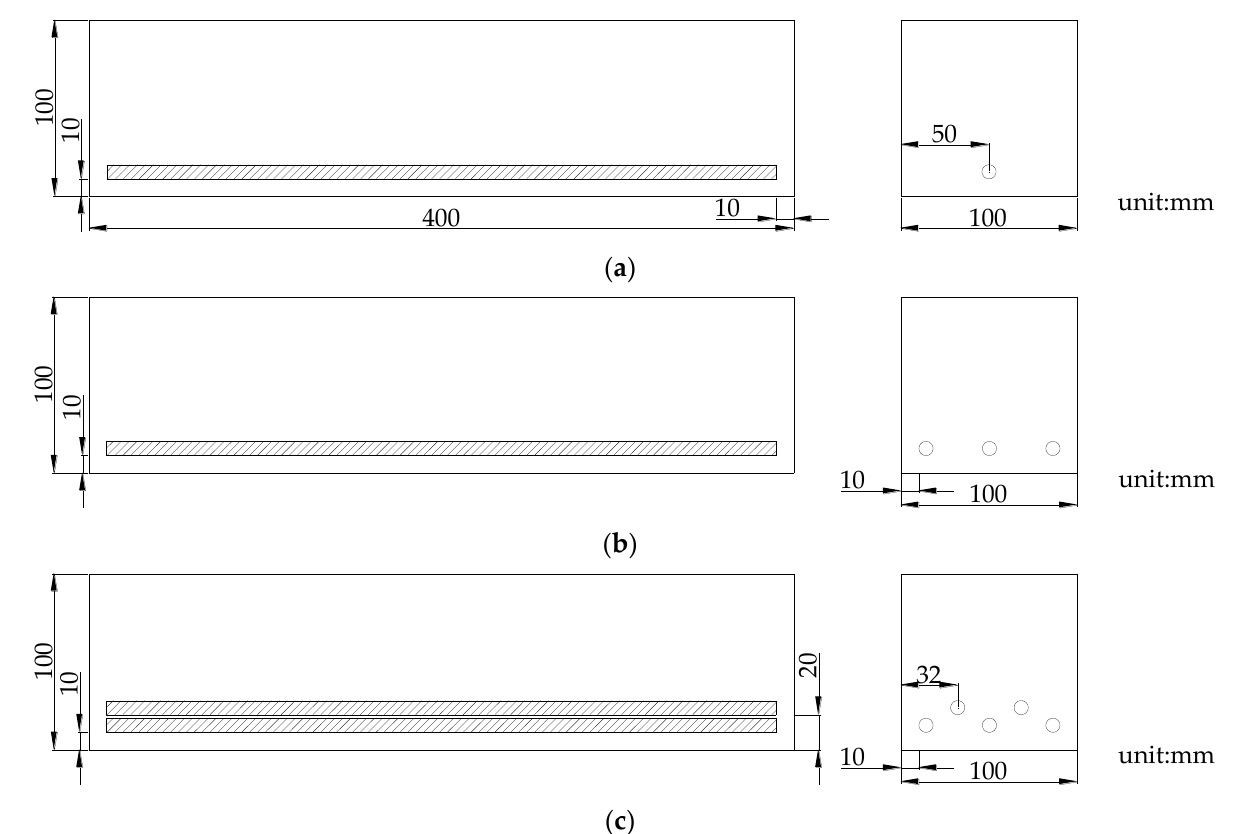
Figure 2. Schematic diagram of the steel bar reactive powder concrete (SBRPC): ( a ) SBRPC-1; ( b ) SBRPC-3; ( c ) SBRPC-5.